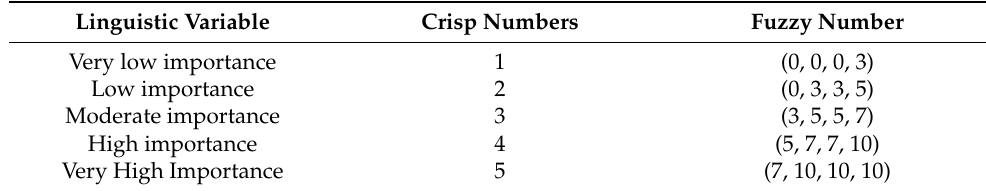
Table 1. Linguistic variable, crisp and fuzzy numbers for the importance weight. Linguistic